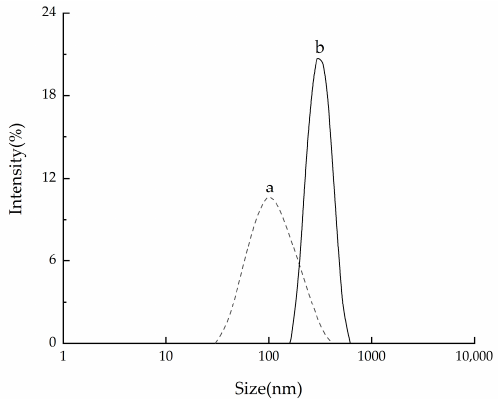
Figure 7. Size distribution of CNCs with different methods. a: the extracted CNCs hydrolyzed in 65.0 wt% H 2 SO 4 at 45 °C for 5 h; b: the CNCs extracted with swelling − SA − catalyzed hydrolysis method at 45 °C for 5 h.